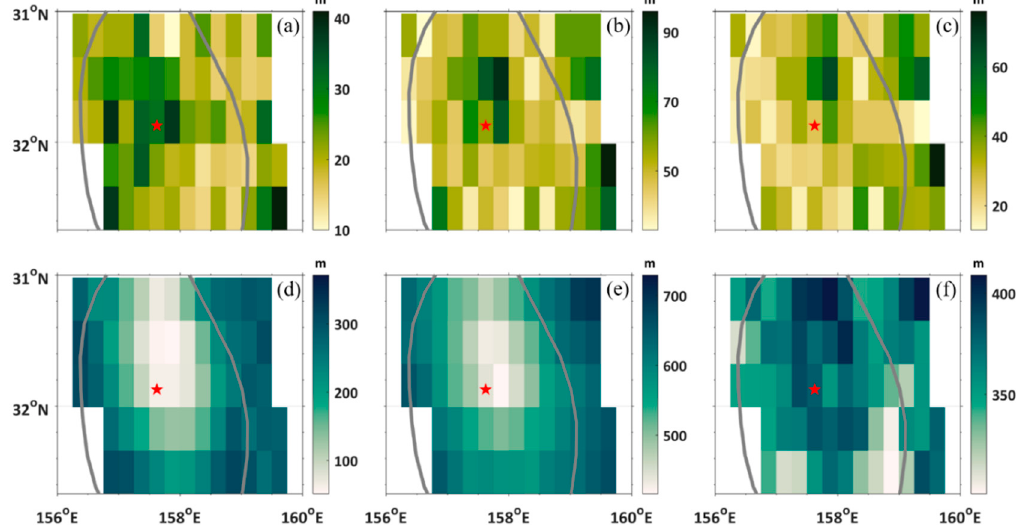
Figure 6. Mixed layer, seasonal and permanent thermoclines. ( a ) Mixed layer depth (MLD), which is also the upper boundary of the seasonal thermocline. ( b ) The bottom of the seasonal thermocline. ( c ) The thickness of the seasonal thermocline. ( d ) The depth corresponding to the upper boundary of the permanent thermocline, which is along the contour of 25.5 σ θ . ( e ) The depth corresponding to the lower boundary of the permanent thermocline, which is along the contour of 26.7 σ θ . ( f ) The thickness of the permanent thermocline. The MLD is determined as the depth with temperature change of 0.5 ◦ C from the ocean surface to this depth. The seasonal and permanent thermoclines are determined here by vertical temperature gradients larger than 0.05 °C/m and 0.02 °C/m, respectively.